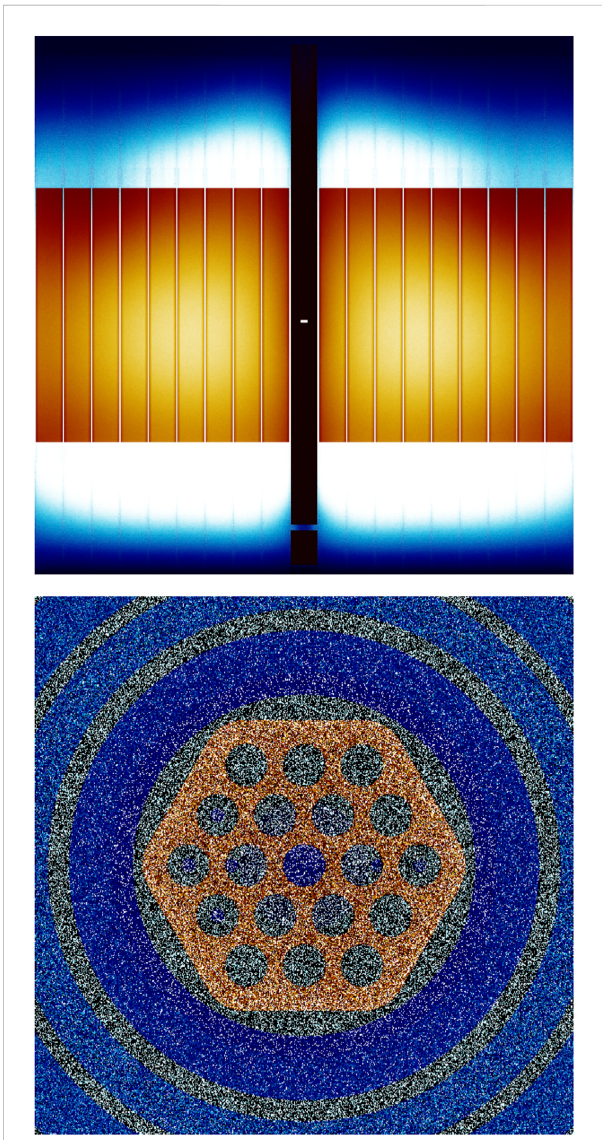
Serpent model of TREAT for SIRIUS calibration experiment: Vertical view of core (Top) and horizontal view of test fuel